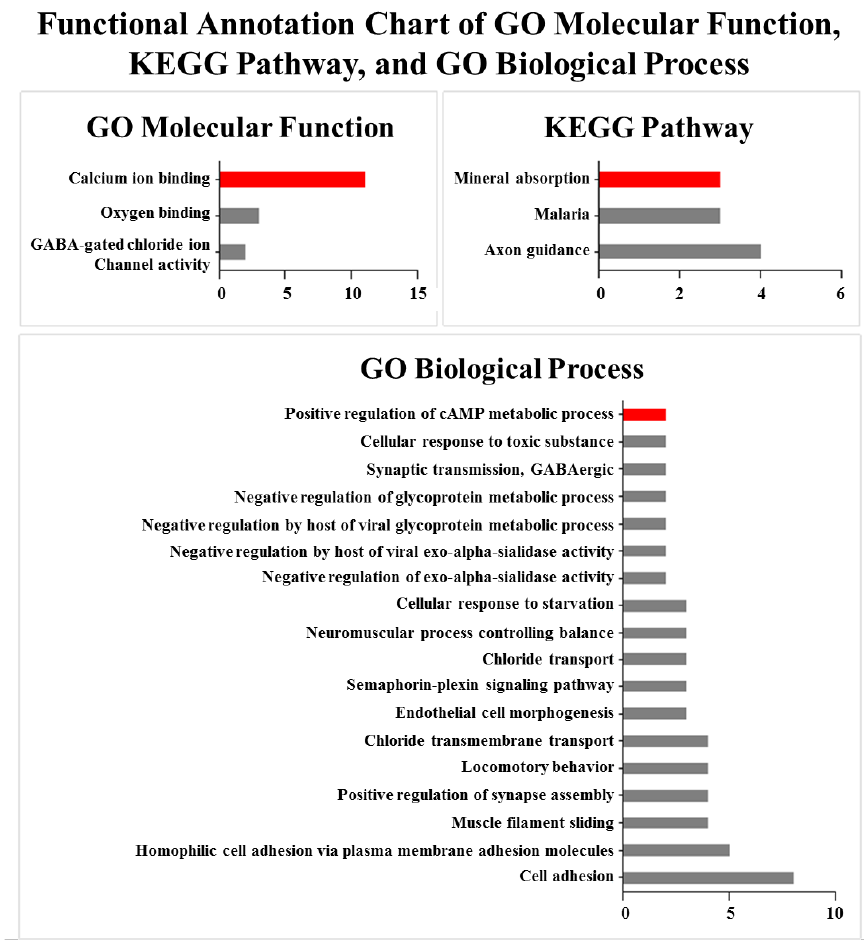
Figure 4. Results of functional enrichment analysis of DE genes between high- and low-FE pigs in genes ontology (GO) molecular function, Kyoto Encyclopedia of Genes and Genomes (KEGG) pathway, and GO biological